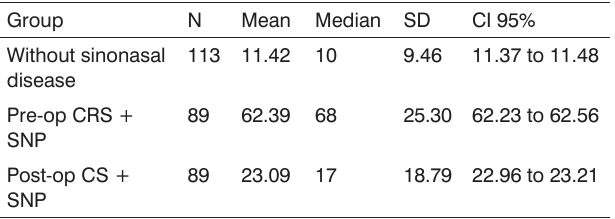
Table 1. Characteristics of the total scores of the groups studied.